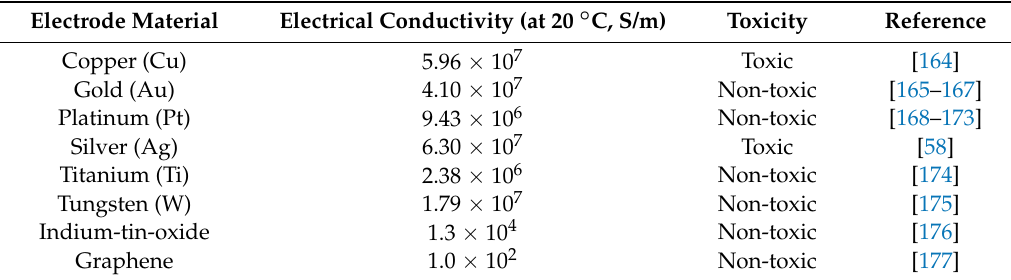
Table 2. Properties of electrode materials.